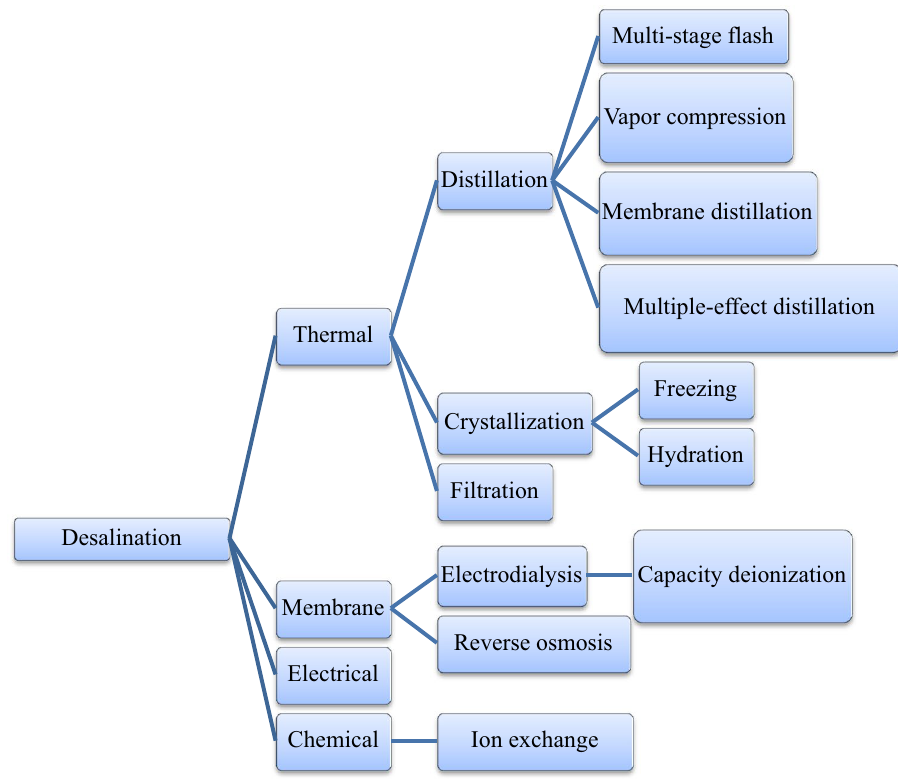
Fig. 3 Classification of desali- nation technology based on pro- cess and energy consumption